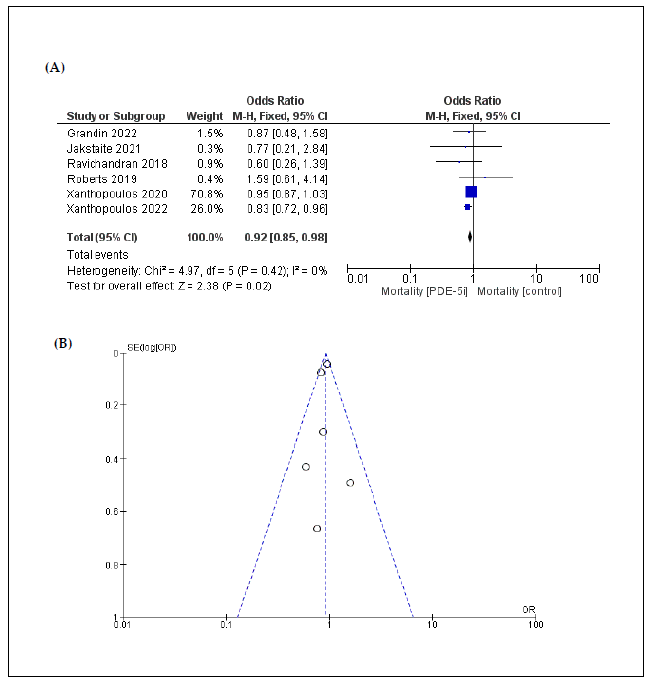
Figure 2. ( A ) Forest plot describing the differences in mortality between the 2 groups (PDE ‐ 5i vs. control); ( B ) funnel plot assessing the publication bias for